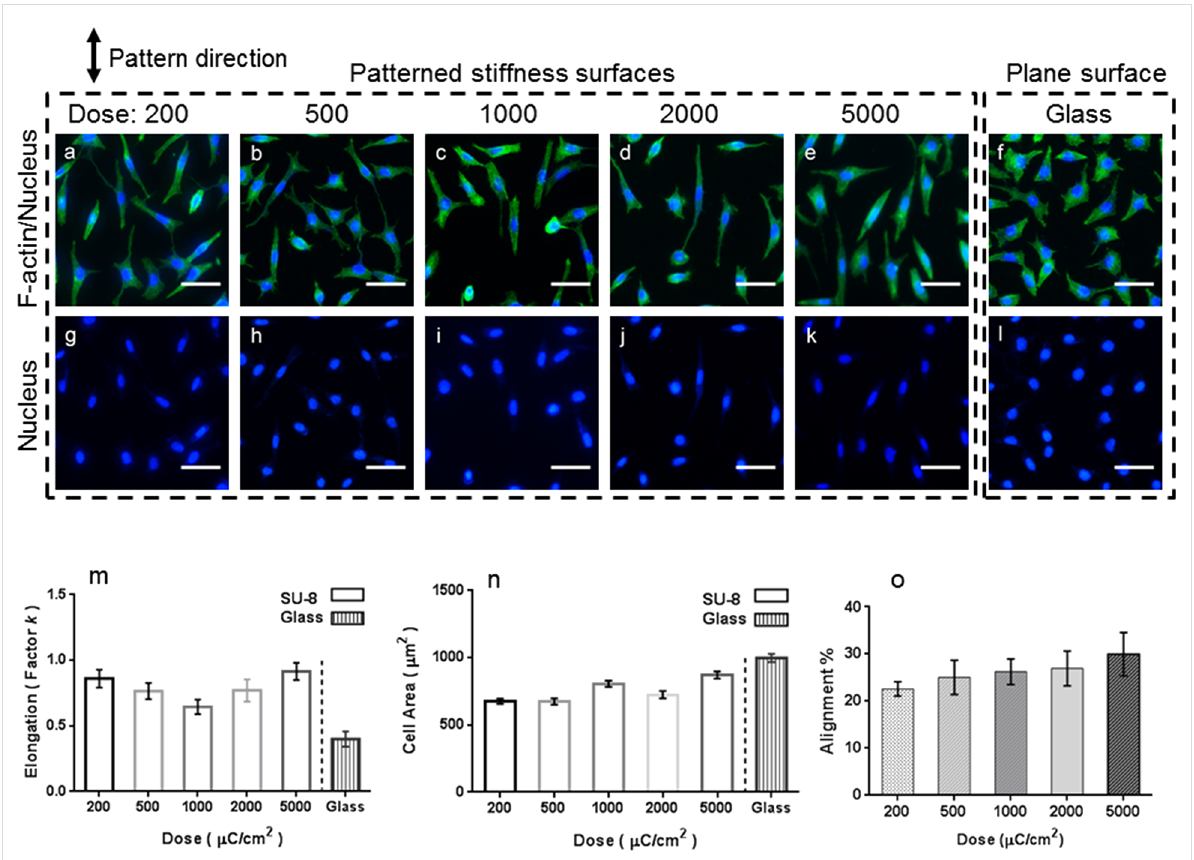
Figure 3: Comparison of the growth of the L929 cells on the SU-8 substrates of varying stiffness and on the reference glass substrate. Fluorescence micrographs of the L929 cells with stained F-actin (a–f) and stained cell nuclei (g–l) on the undeveloped SU-8 films exposed to different EBL doses and on the reference glass substrate. The stripes are vertically aligned. The cell nuclei were stained blue with DAPI, and F-actin was stained green with Alexa Fluor 488. (m) Elongation of the cells on the patterned stiffness surfaces and on the reference glass substrate. (n) Size of the cells on the patterned stiffness surfaces and on the reference glass substrate. (o) Alignment rate (alignment %) of the cells on the patterned stiffness substrates. (Data are expressed as the mean ± standard error of mean (s.e.m.) of four samples, n = 50 cells). Scale bars: 20 μ m.